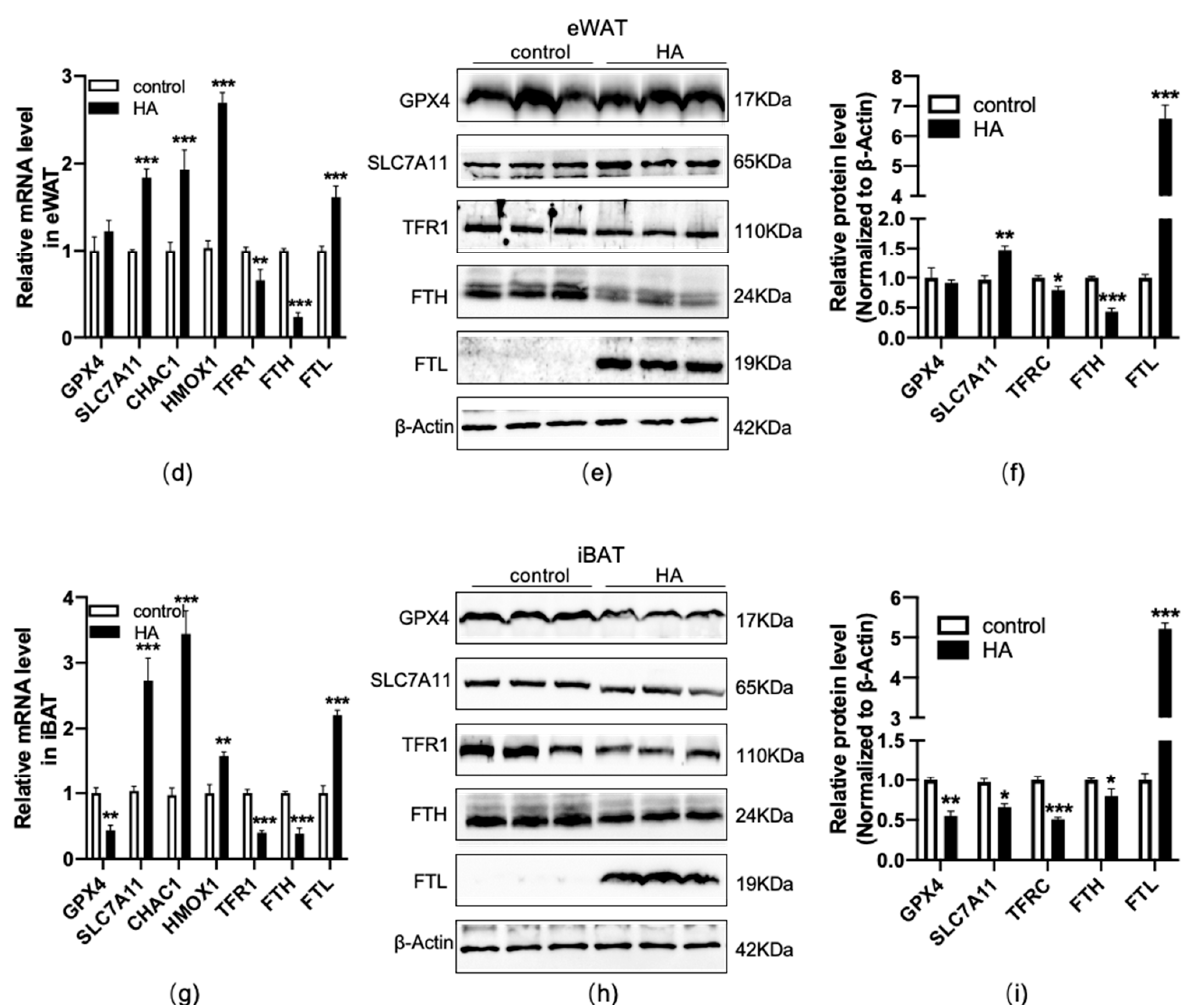
Figure 6. Changes in ferroptosis-related genes and proteins in adipose tissue during HA exposure. Graphs ( a , d , g ) display RT − qPCR of ferroptosis-linked genes and iron metabolism-related genes after HA exposure. Data are expressed as the mean ± SEM; n = 6. Graphs ( b , e , h ) display representative bands of ferroptosis-related protein levels; n = 3. Graphs ( c , f , i ) display quantification of the relative protein levels, normalized to β -actin. * p < 0.05, ** p < 0.01, and *** p < 0.001, compared with the control